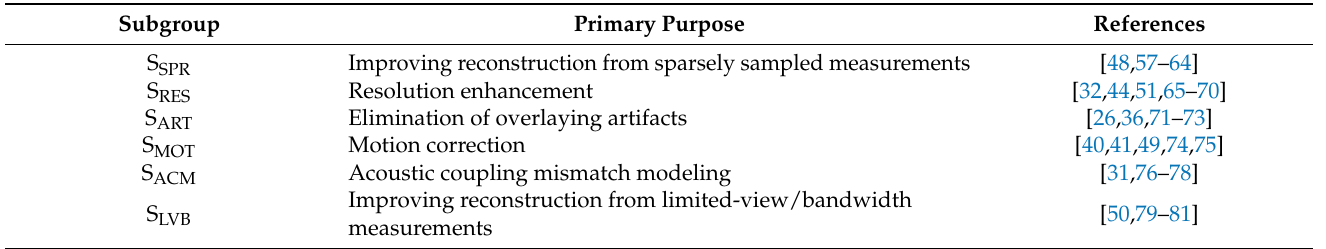
Table 2. Summary of the assignment of studies to different